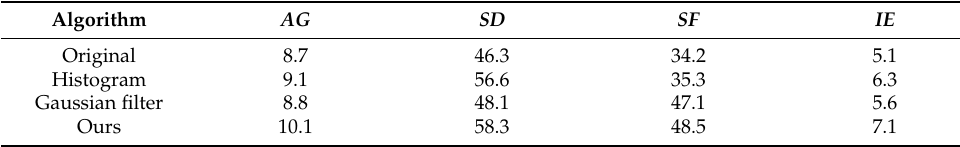
Table 1. Short coastline image quality.